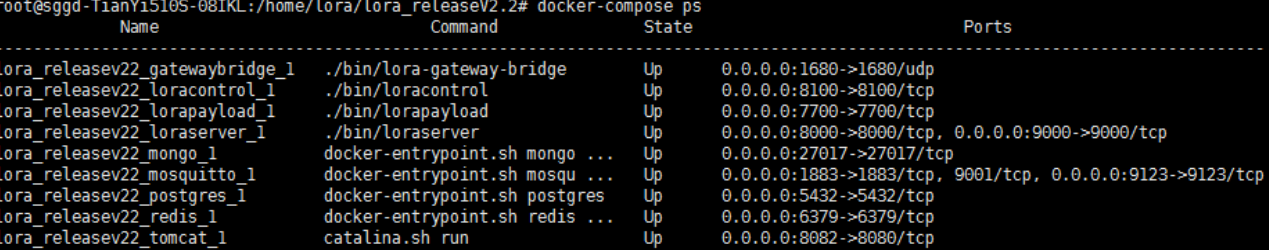
Figure 18. The successful startup of the middleware software.